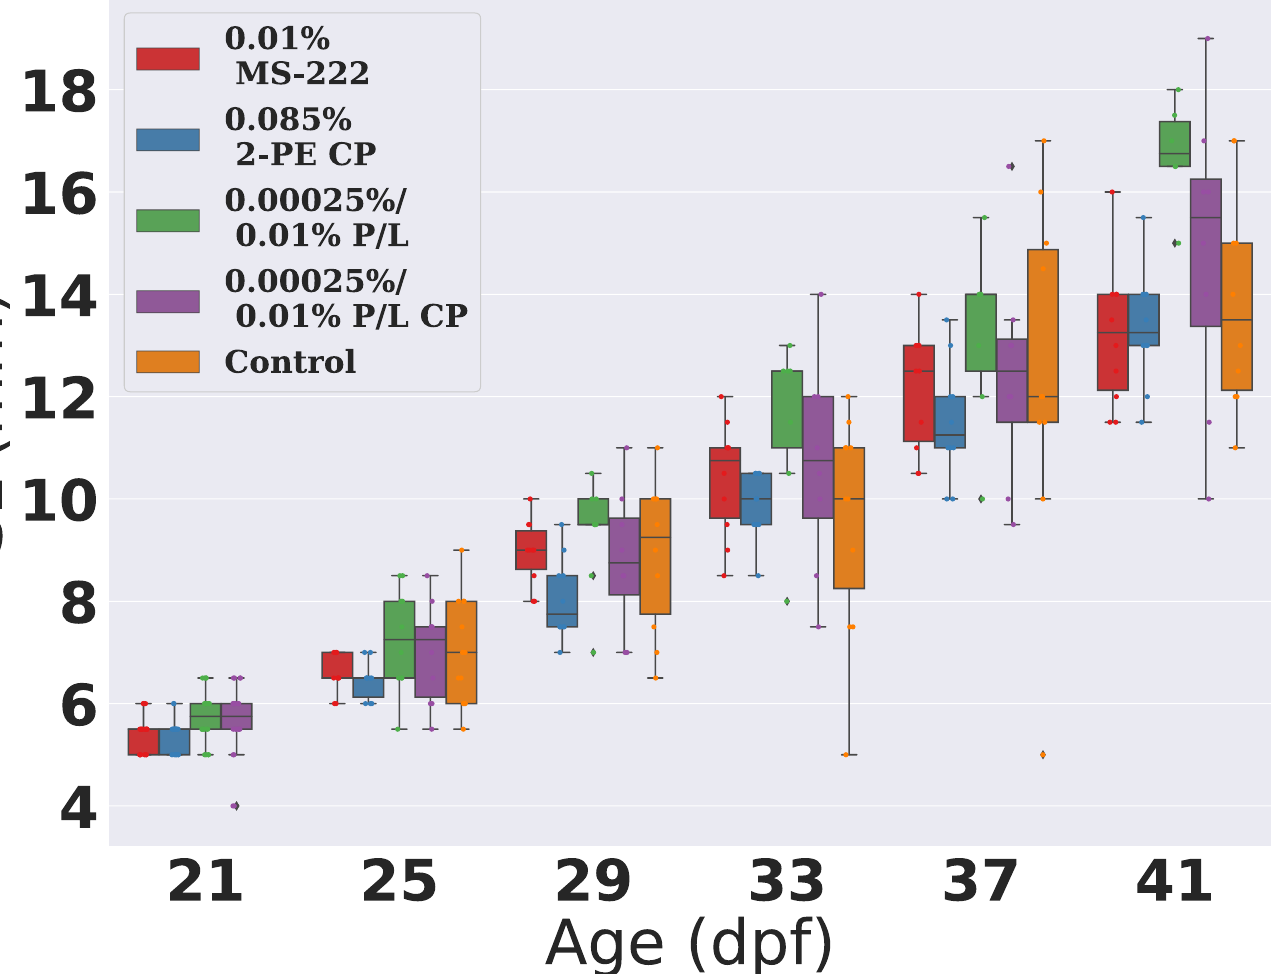
Unexpectedly, at the end of the experiment fish from protocol 5 were significantly longer than